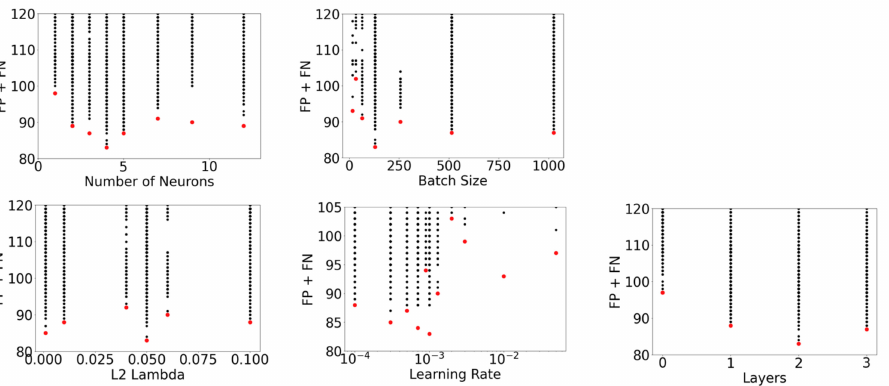
Figure 9. Model performance from 1D slices of the multidimensional hyperparameter search, as mea- sured on the test dataset. Best models are indicated by a red marker, and all other models are indicated by a black marker. Top panel: number of neurons and batch size; bottom panel: L2 lambda, learning rate and